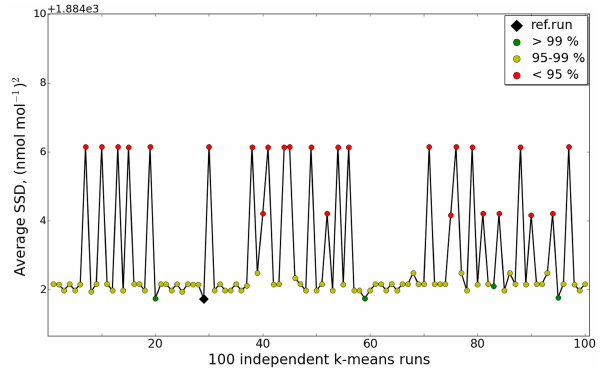
Figure 20. Averaged SSD for 100 independent k -means runs with cluster number k = 5 for all runs; first set of properties. Percentage ranges in legend indicate similarity of corresponding k -means runs with the first CA reference run presented in this work (black dia- mond dot). First category: five runs with > 99% similarity; second category: 70 runs with 95–99% similarity; third category: 25 runs with < 95% similarity (always at least 89% similarity).